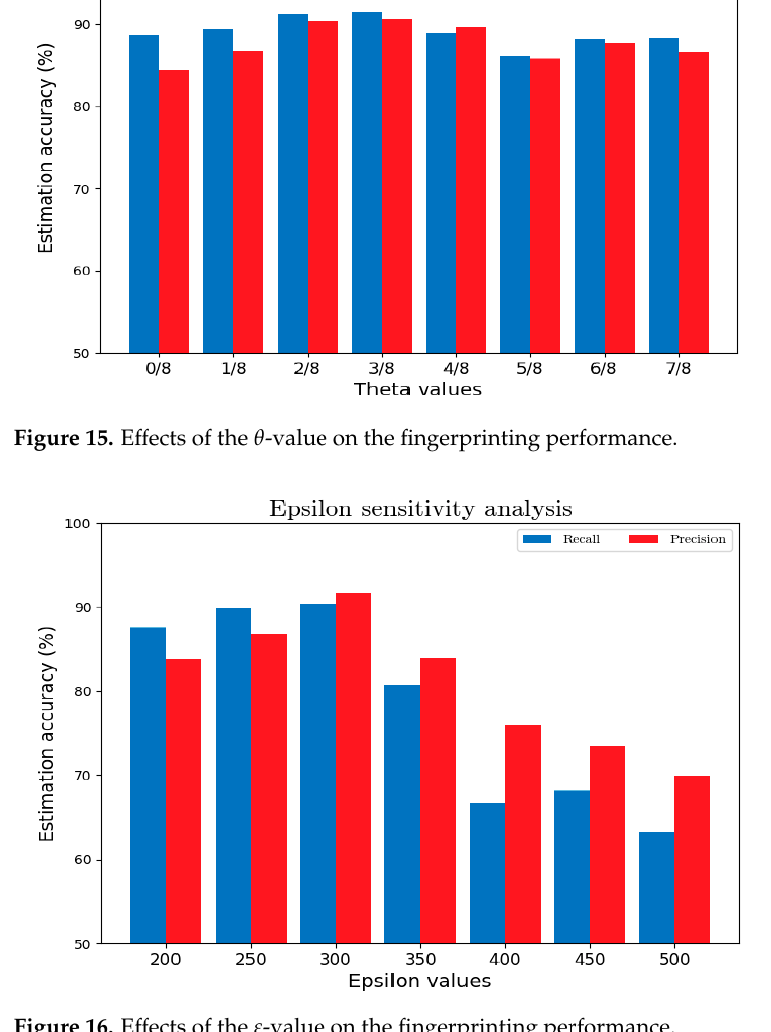
Sensors 2022 , 22 , x FOR PEER REVIEW